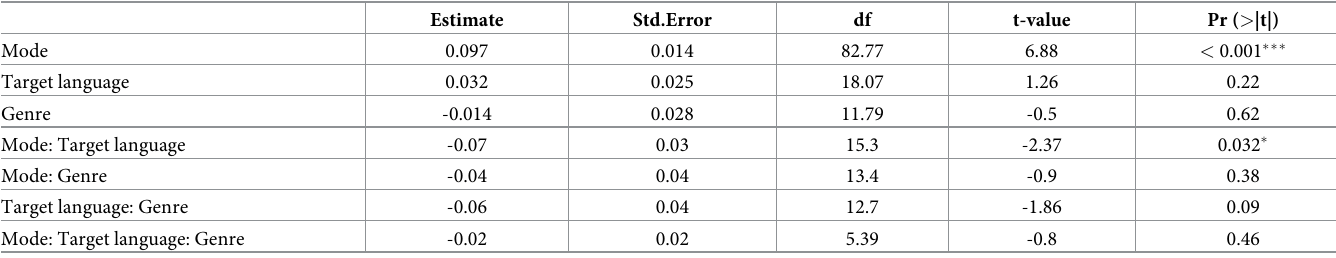
Table 2. Model results for average fixation duration in ST.